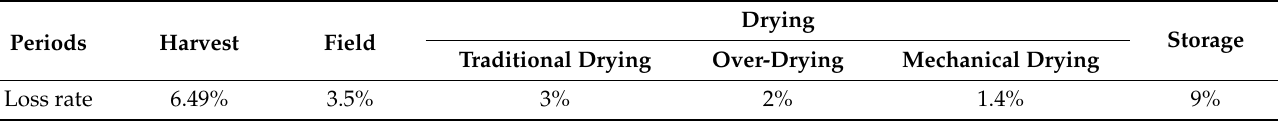
Table 8. Rice loss rate in traditional harvesting methods in different periods.